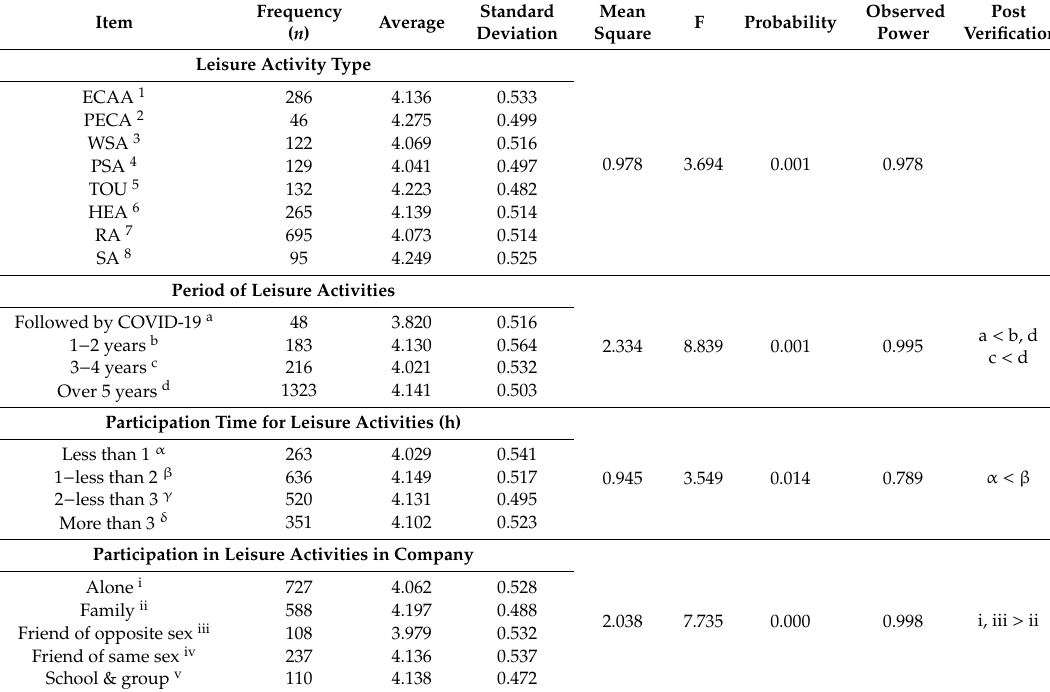
Table 2. Analysis of the di ff erences in COVID-19 preventive behaviors as per participation in leisure activities.